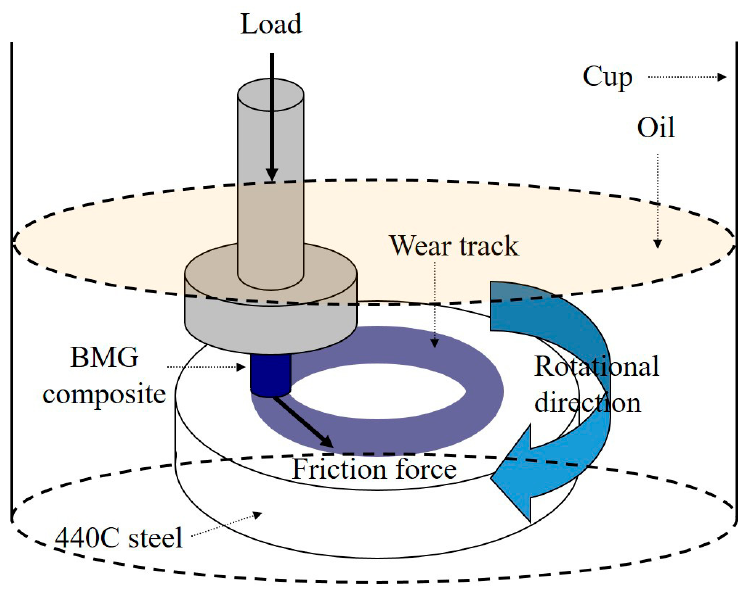
Figure A1. Illustration of pin-on-disk apparatus for lubricated sliding wear test.